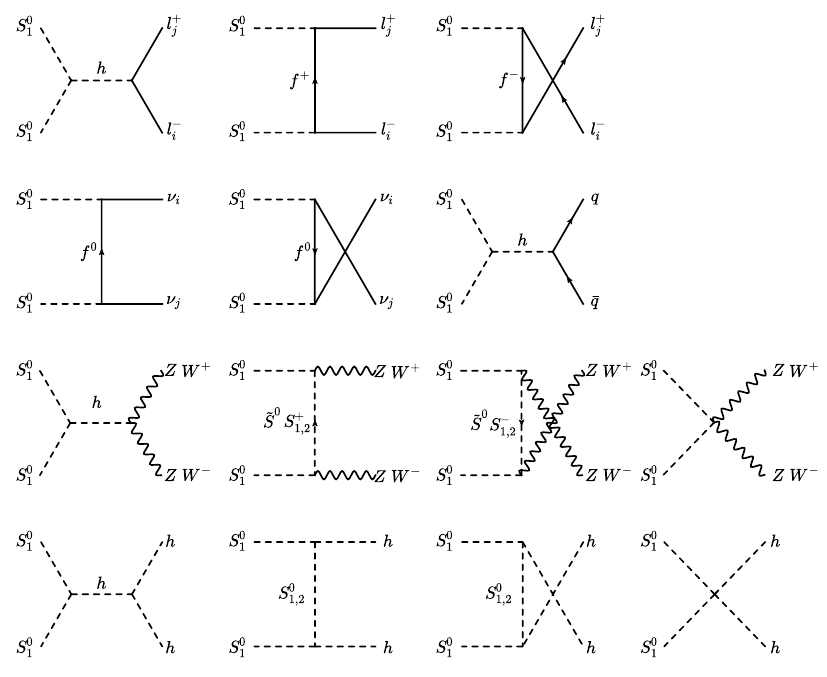
Figure 2 . Dark Matter annihilations into SM